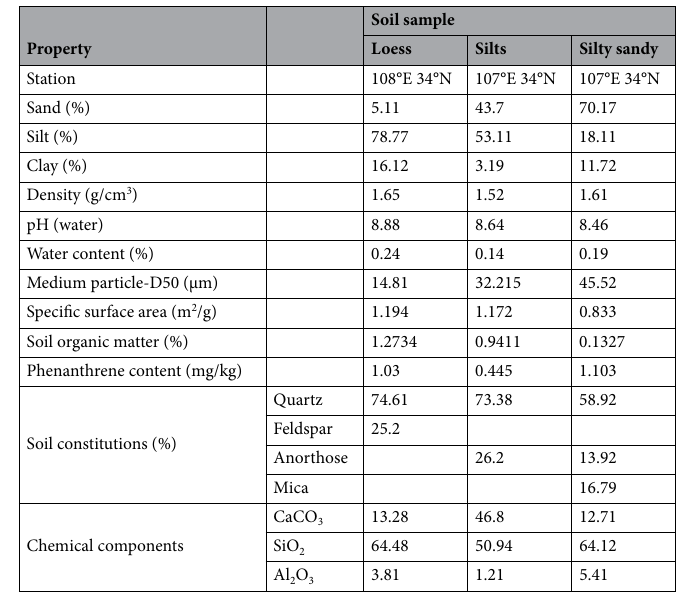
Table 1. Sampling stations of soil and their characteristics. In order to make the data clear, the coded values are used for organic matter.